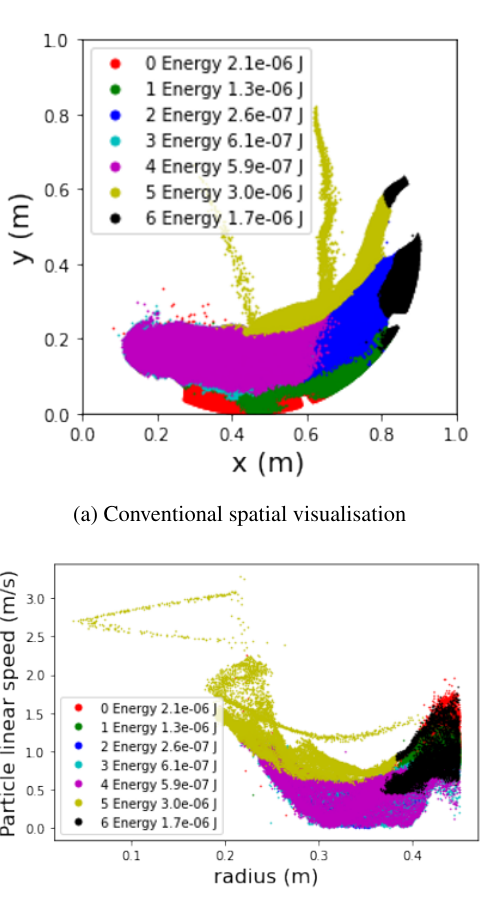
Figure 3: Standard spatial visualisation of raw information.